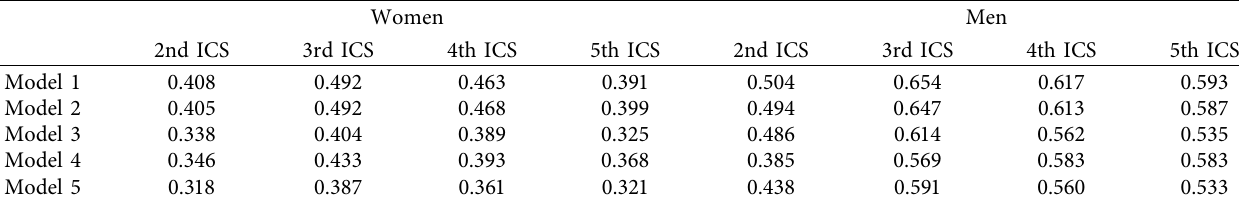
Table 3: R 2 of proposed